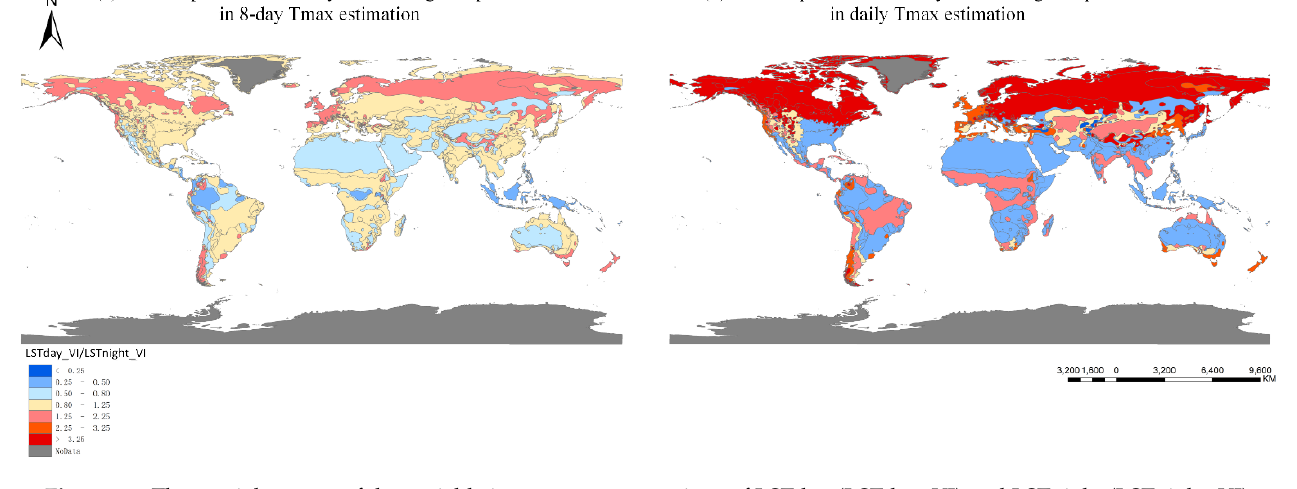
Figure 10. The spatial pattern of the variable importance comparison of LSTday (LSTday_VI) and LSTnight (LSTnight_VI) in 8-day Tmax ( a ) and daily Tmax estimation ( b ) based on the results on a climate zone scale. The color shows the variations of the ratio of LSTday_VI and LSTnight_VI.